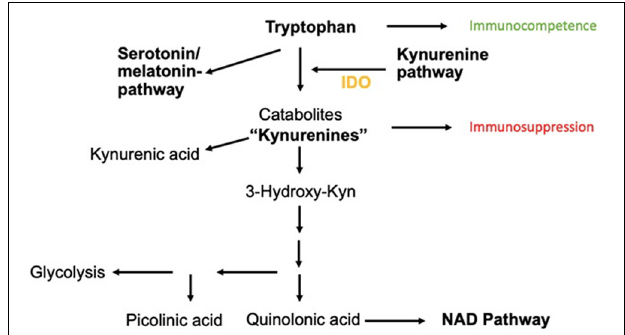
FIGURE 1 | Catabolism of Trp via Kyn-pathway. The neuroinflammatory metabolites kynurenic acid, picolinic acid, and quinolinic acids are shown as well as the transition to the NAD pathway important for cellular energy